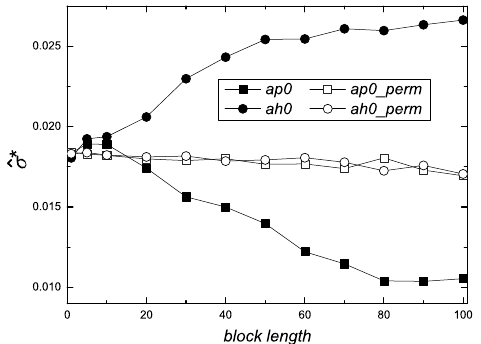
Figure 4 – Moving Block Bootstrap estimates ˆ σ ∗ of the standard error of p as a function of the block length l , for the parity ( ap0 , full squares) and hidden ( ah0 , full circles) codon classes, both computed with no frame shift for the anticodon sequence U53218 (coding region), with n = 739. Results obtained by applying the MBB to the same codon classes, but with the original DNA base sequence randomly permuted are reported in empty symbols ( ap0_perm and ah0_perm